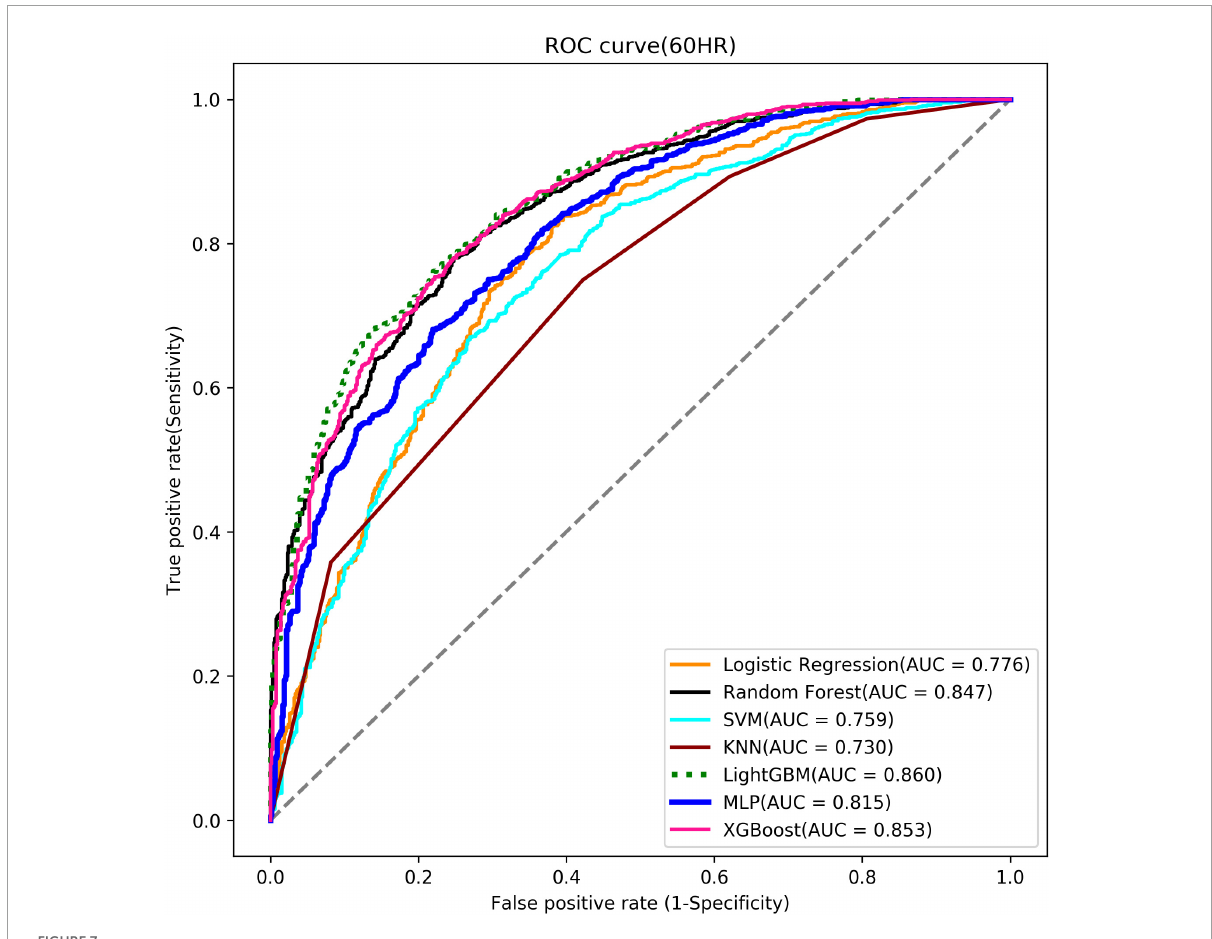
FIGURE7 Stage 1 ROC curve (the 60th Hour